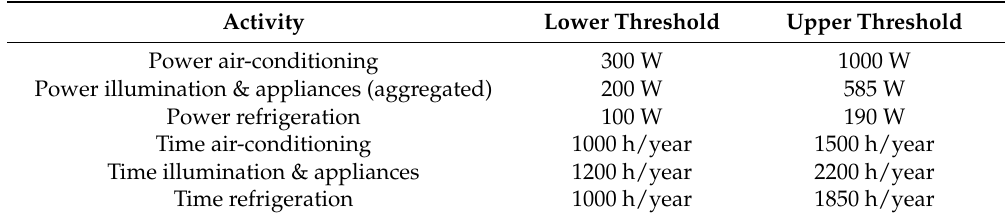
Table 6. Lower and upper limits of power and time of use of the energy activities of the Mexican residential sector [35,36].